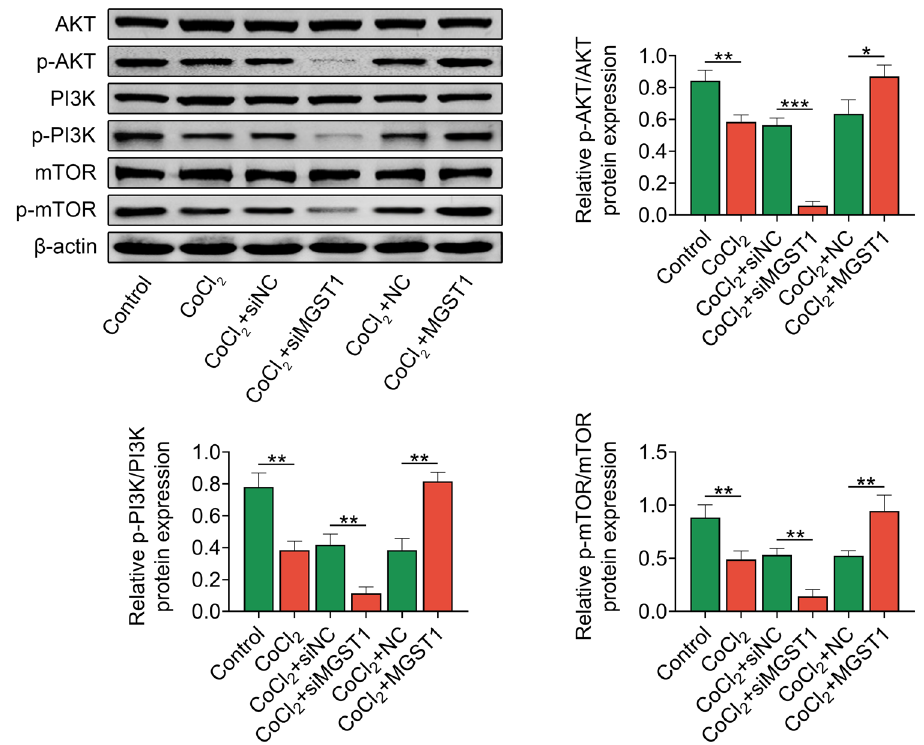
Figure 4: MGST1 activated PI3K/AKT/mTOR pathway. Groups were divided into the control, CoCl 2 , CoCl 2 + siNC, CoCl 2 + siMGST1, CoCl 2 + NC, and CoCl 2 + MGST1 group. Western blot analysis assessed the levels of PI3K/AKT/mTOR pathway - associated proteins ( AKT, p - AKT, PI3K, P - PI3K, mTOR, and p - mTOR ) . * P < 0.05, ** P < 0.01, *** P <